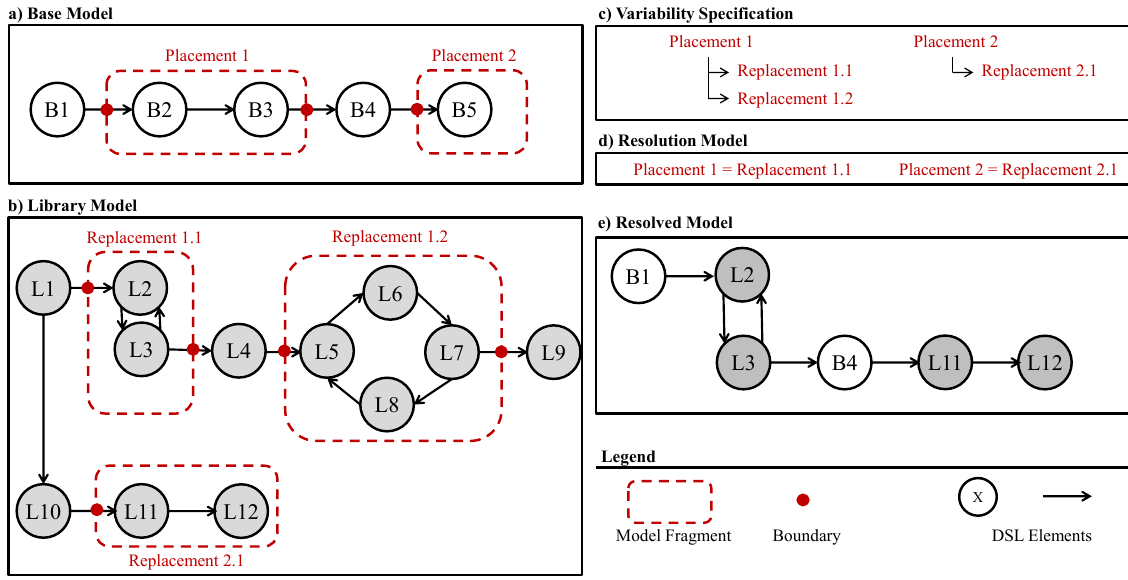
Figure 1. Variability of model fragments in